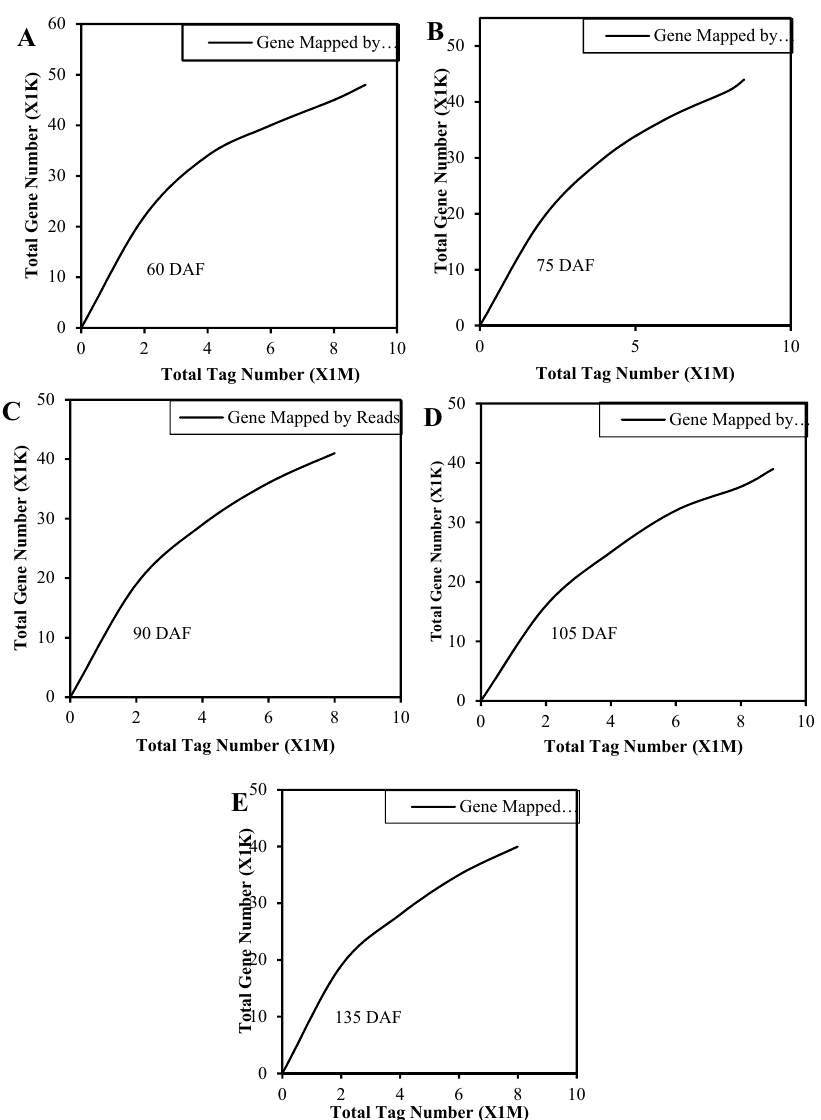
Figure 2. Saturation curve analysis of the digital gene expression tag libraries. ( A )–( E ) represents 60 DAF, 75 DAF, 90 DAF, 105 DAF and 135 DAF, respectively. Data are shown as the reads number (X-axis, M represents million) and number of expressed genes (Y-axis, K stands for 1000) obtained using sequencing.